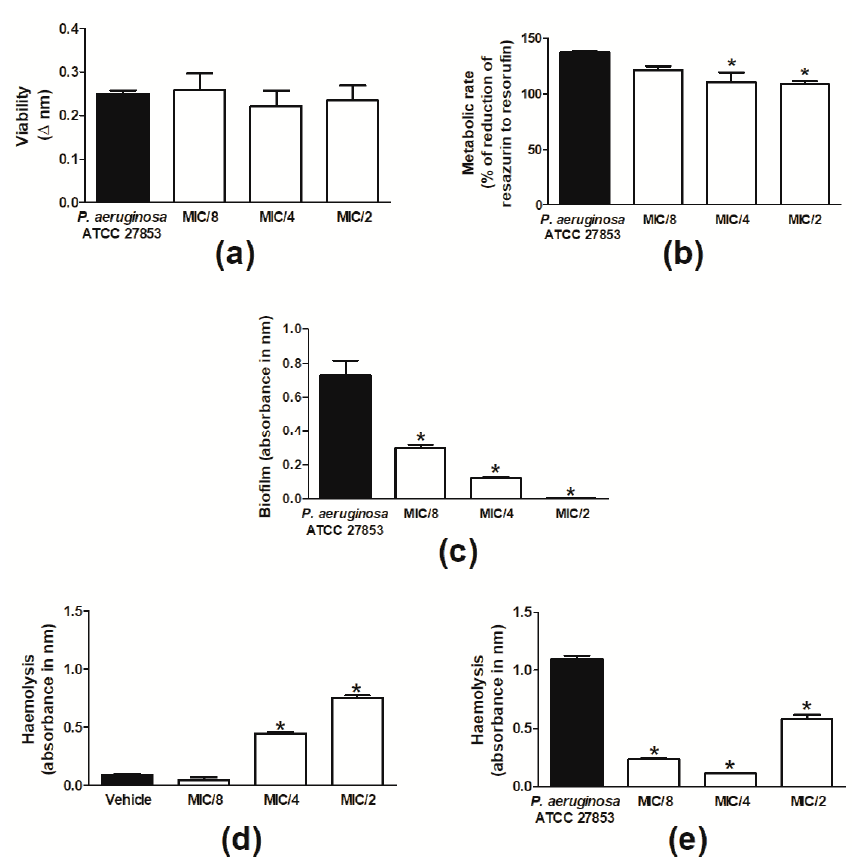
Figure 1. E ff ects of sub-inhibitory concentrations of cinnamaldehyde on P. aeruginosa . P. aeruginosa ATCC 27853 ( a ) viability ( ∆ nm) and ( b ) metabolic rate (as percentage (%) of reduction of resazurin to resorufin). ( c ) Biofilm formation and ( e ) haemolysis induced by P. aeruginosa ATCC 27853. E ff ect of sub-inhibitory concentrations of cinnamaldehyde on erythrocytes in the absence of bacteria ( d ). Cinnamaldehyde was tested at MIC / 2, MIC / 4 and MIC / 8. Vehicle (2% DMSO in PBS)-treated bacteria were used as controls. * p < 0.05, di ff ers from the vehicle-treated group. n =